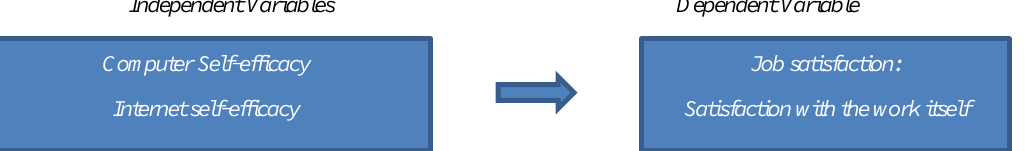
Figure 1: The conceptual framework reflects the influence of computer self-efficacy and internet self-efficacy on job satisfaction; Source: John R. Otte (2019), Michael Glassman (2013), Blais, Lachance, Forget, Richer, & Dulude (1991). Statement of the